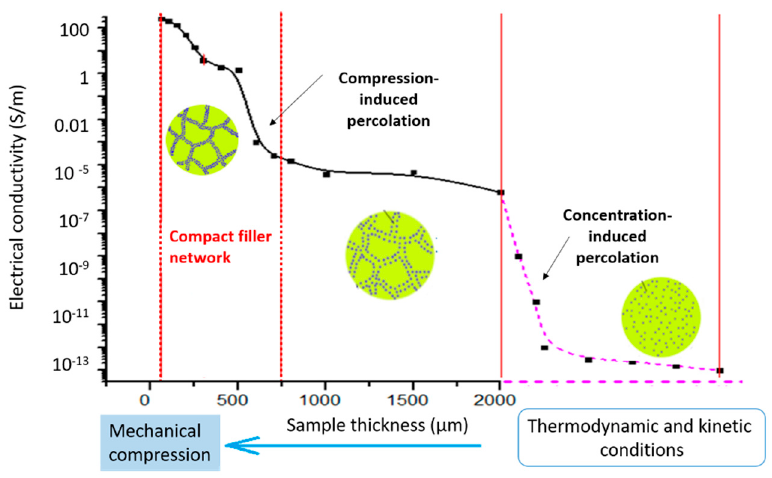
Figure 6. Mechanism of the SCFNA process initiated compact conducting filler network and highly enhanced electrical conductivity of polymer composites.